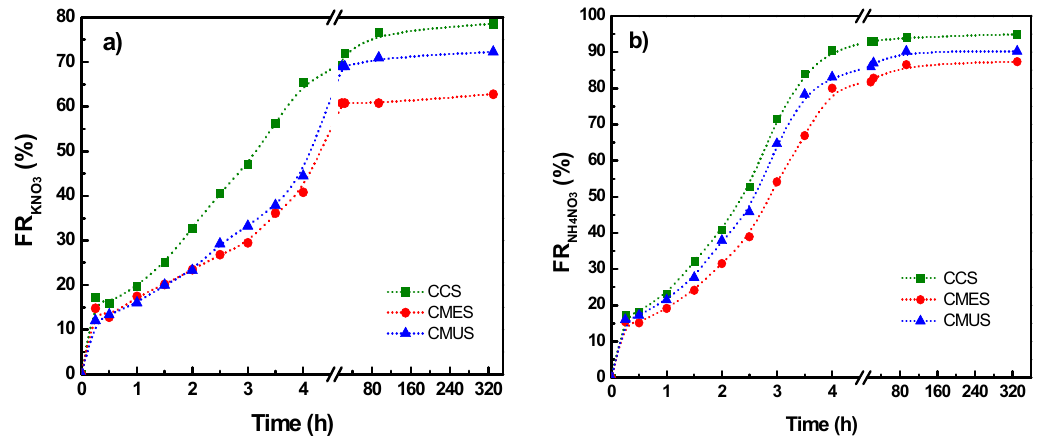
Figure 9. Release kinetics of ( a ) KNO 3 with an initial loading concentration of 10 g/Land ( b ) NH 4 NO 3 at with an initial loading concentration of 0.5 g/L on grafted starches.